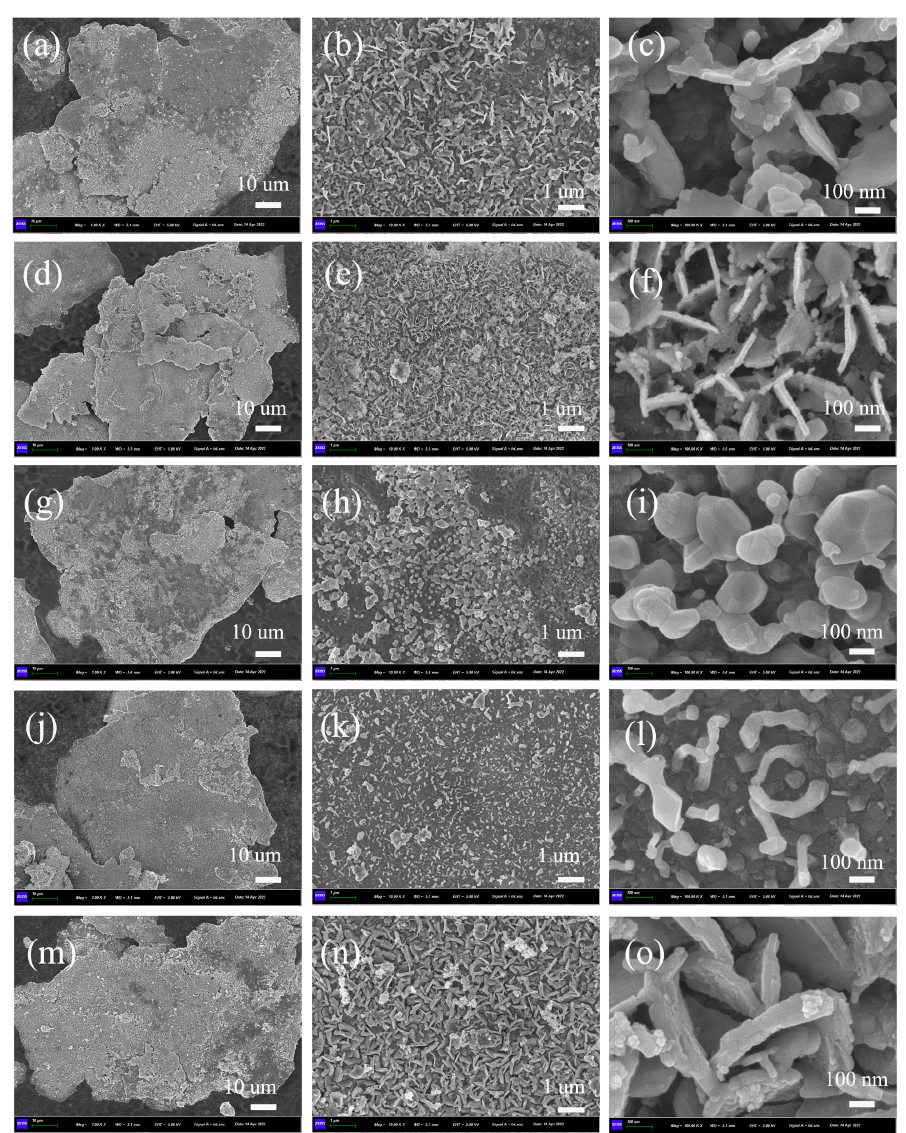
Figure 4. SEM of flaky FeSiAl composites coated with MFe 2 O 4 ; M = ( a – c ) Mn, ( d – f ) Co, ( g – i ) Ni, ( j – ◦ l ) Cu, ( m – o ) Zn annealing at 800 °C. ( j – l ) Cu, ( m – o ) Zn annealing at 800